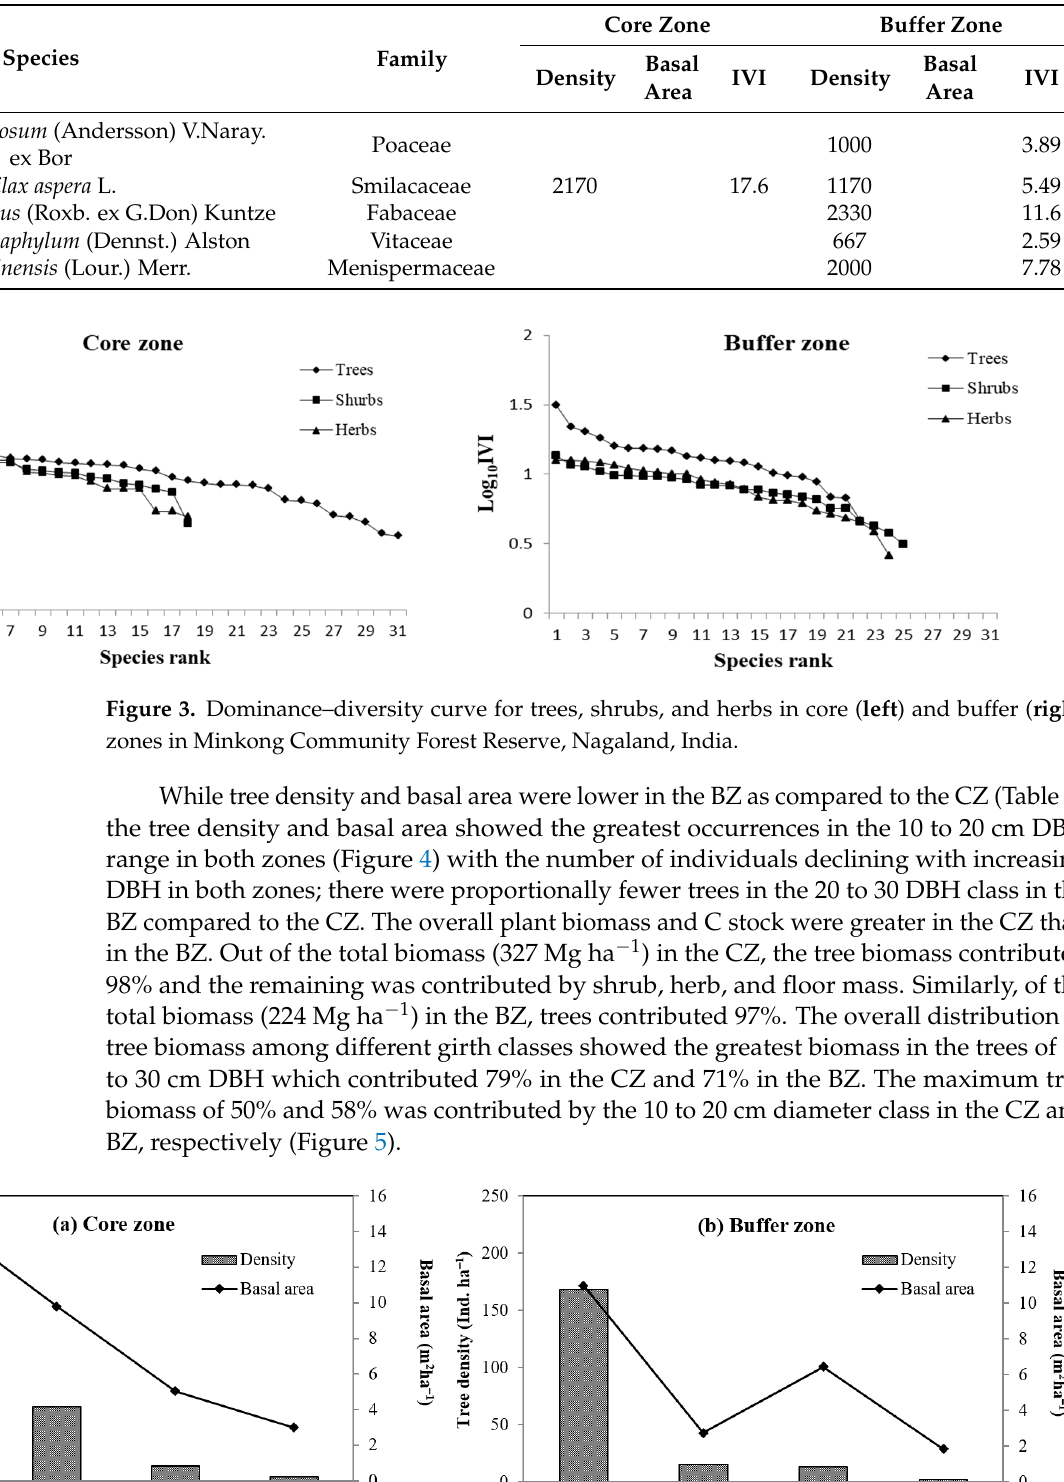
Figure 4. Contribution of tree stand density and basal area based on diameter class distributions in the core ( a ) and buffer ( b ) zones in Minkong Community Forest Reserve, Nagaland, India.